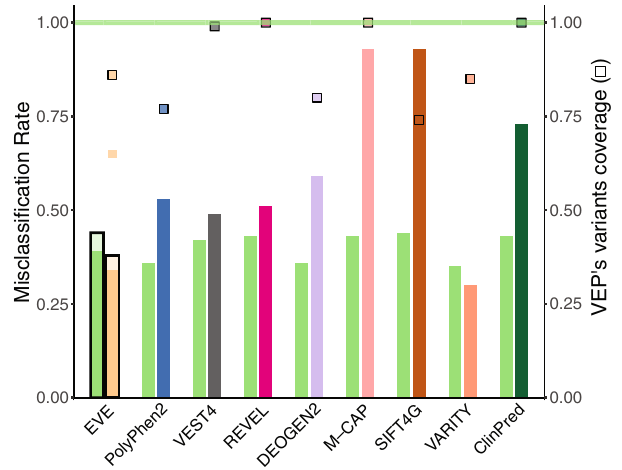
Fig. 6 | Comparison of VEPs on population data. Misclassi fi cation rate of benign common variants within the Estonian Biobank. The test set constitutes of 94 var- iants. On the y axis the misclassi fi cation rate and on the second y axis the VEP ’ s variants coverage, identi fi ed by the colored squares. The green horizontal line ( y =1) shows that DeMAG has 100% coverage, as wells as REVEL, M-CAP and ClinPred. Among those tools DeMAG reaches the lowest misclassi fi cation rate. VARITY reaches the lowest misclassi fi cation rate but covers only 80% of variants. The comparison with EVE has 2 error bars: the fi rst (black border and transparent color) indicates the performance when uncertain class variants are predicted as if EVEwasarandomclassi fi er,theinner(andshorter)barindicatesEVE ’ sperformance excluding uncertain variants. While EVE has lower misclassi fi cation rate than DeMAG, itonly gives certain predictions for 65% of variants. Although VARITYand EVEclassifythese94variantswiththelowestmisclassi fi cationrate,DeMAGhasthe lowest misclassi fi cation rate among VEPs with 100% predictions. For con fi dence intervals calculated on 1000 bootstrap samples refer to Supplementary Fig.